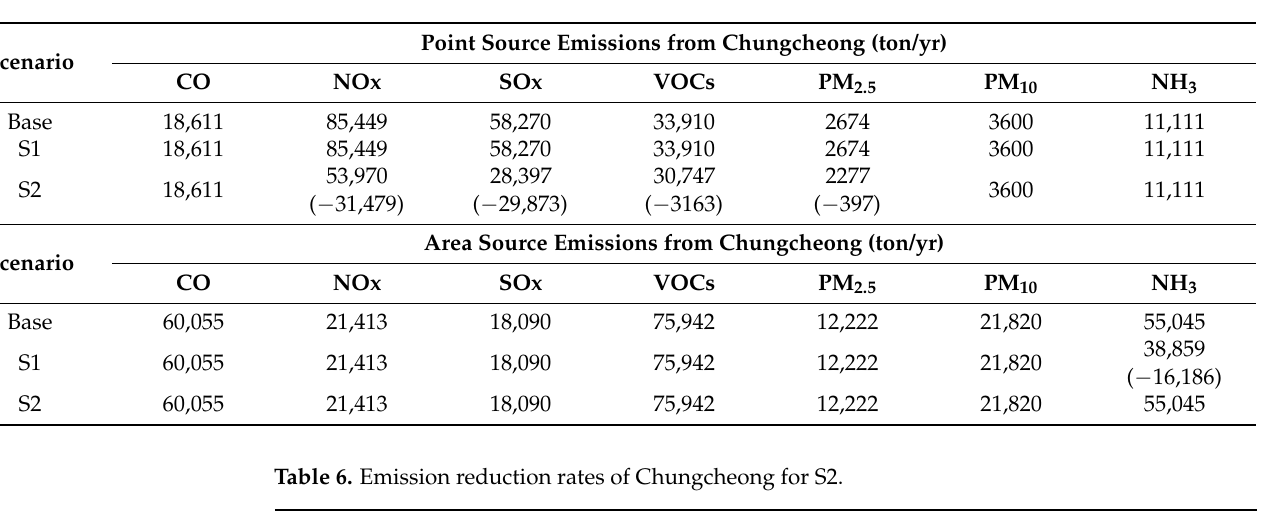
Table 5. Emission inventories for Base case, S1, and S2.